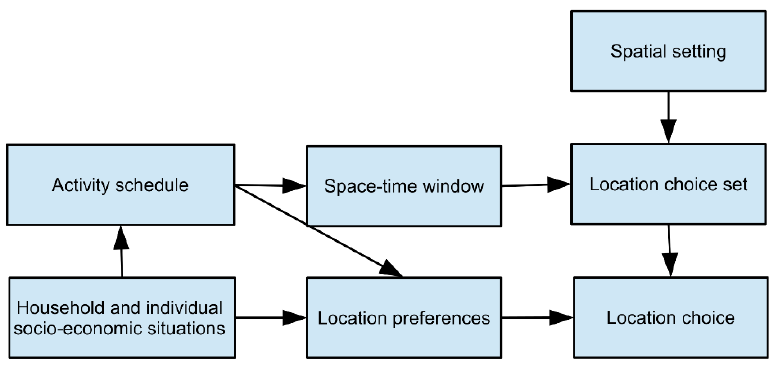
Figure 3. Conceptual framework of location choice determinants (Arentze and Timmermans,